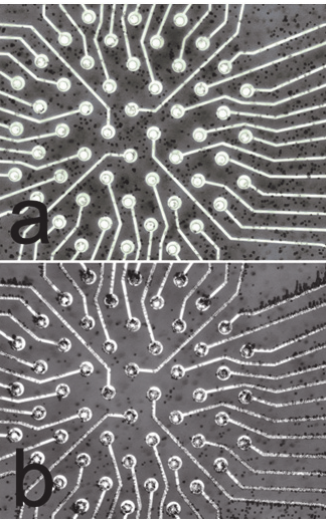
Fig. 14: DP collection of baker's yeast at the electrode pads of a glass neurochip with a 52 microelectrode MEA. The on-chip conducting paths of the MEA were 5 µm wide, insulated by >1µm silicon-nitride and terminated by circular pad openings with a diameter of 25 µm. The rectangular MEA-pad distances were 100 µm. All conducting structures were made from Pt. (a) Sedimented cells after cell seeding; (b) after 2 min of cell collection.